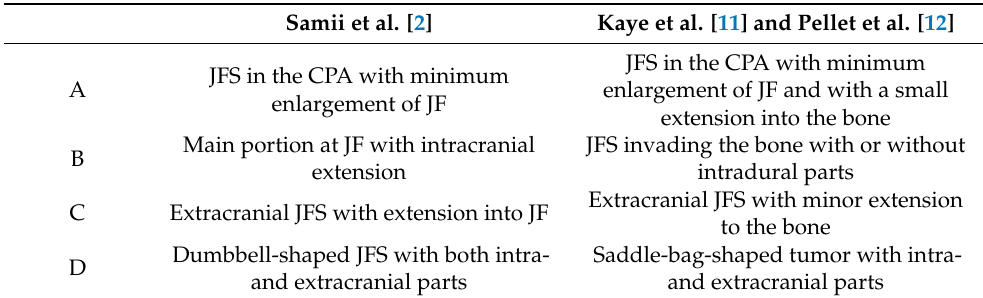
Table 1. Classifications for JFS. Data are shown as CPA, cerebellopontine angle; JF, jugular foramen; JFS, jugular foramen schwannoma. Samii et al. [2] Kaye et al. [11] and Pellet et al. [12] JFS in the CPA with minimum JFS in the CPA with minimum enlargement of JF and with a small A enlargement of JF extension into the bone Main portion at JF with intracranial JFS invading the bone with or without B extension intradural parts Extracranial JFS with minor extension C Extracranial JFS with extension into JF to the bone Dumbbell-shaped JFS with both intra- Saddle-bag-shaped tumor with intra- D and extracranial parts and extracranial